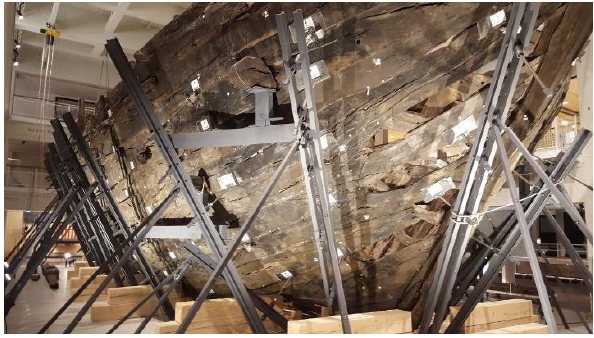
Figure 7. Bremen Cog at the German Maritime Museum